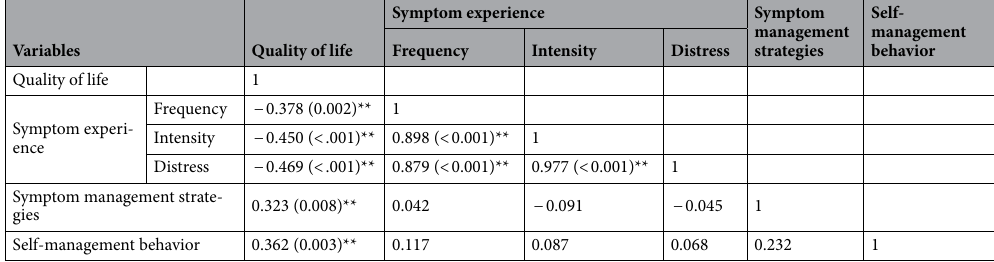
Table 3. Correlations between Symptom Experience, Symptom Management Strategies, Self-Management Behavior, Quality of Life (N = 67) . ** p < .01.